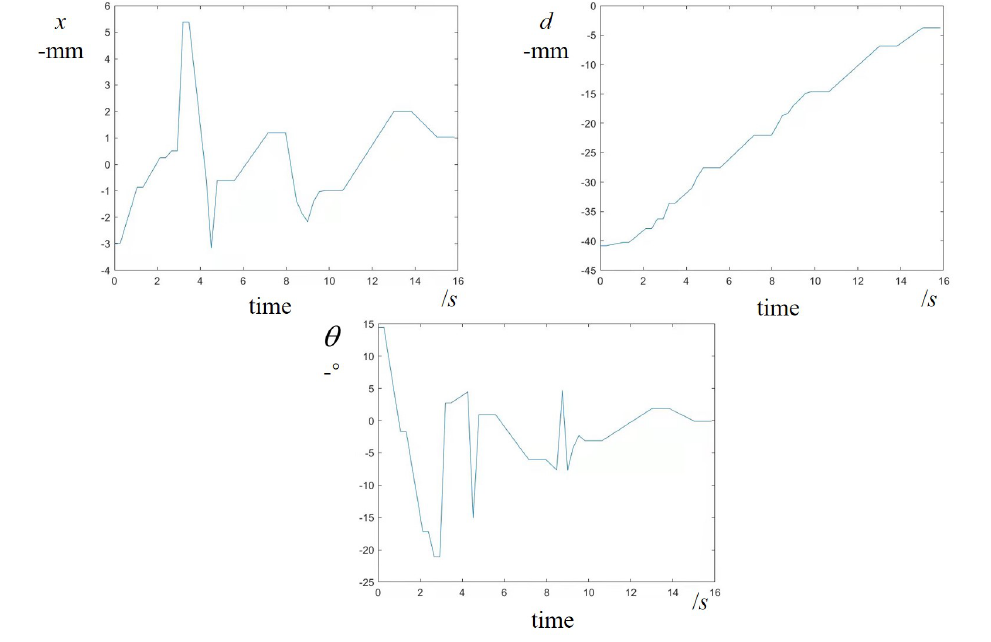
Figure 15. Visual feedback output of a moving SMMRob docking with the front one, depicting the lateral distance, longitudinal displacement, and heading angle.